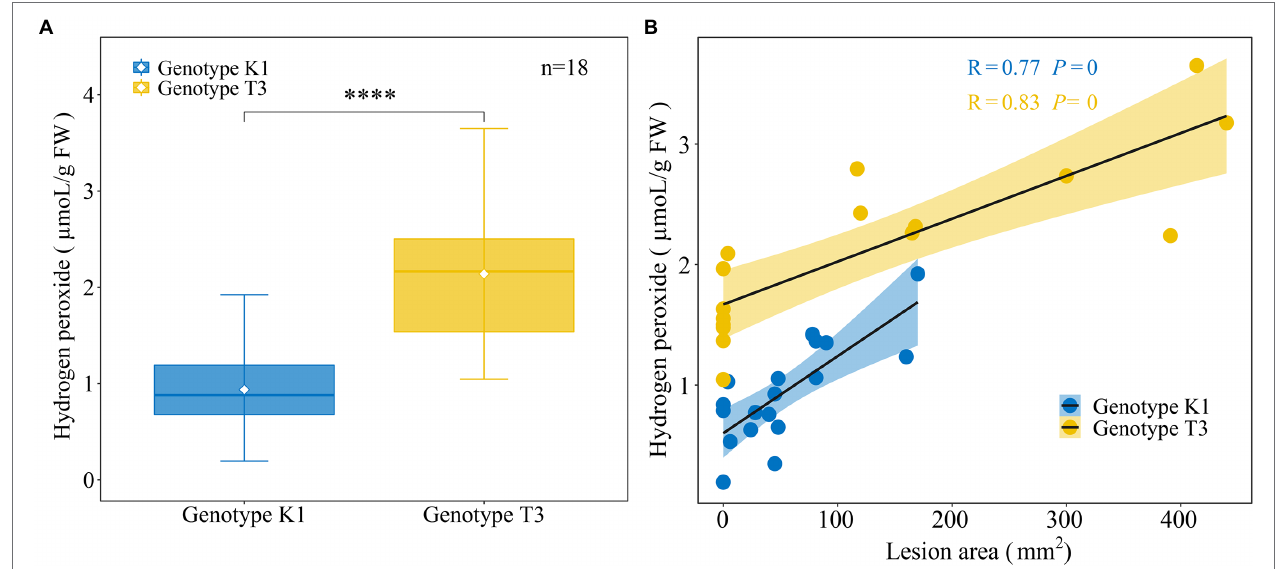
FIGURE 5 | Analysis of H 2 O 2 production of leaves of Kreuzkogel 1 (K1) and Tenno 3 (T3). (A) The amount of H 2 O 2 in strawberry middle and right leaflets for K1 and T3 without B. cinerea inoculation. The asterisk ‘ * ’ indicates significant differences among two genotypes by t -test at p < 0.0001. (B) The correlation between lesion area, measured on strawberry left leaflets at 5 dpi H 2 O 2 in strawberry middle and right leaflets for K1 and T3, respectively, without B. cinerea